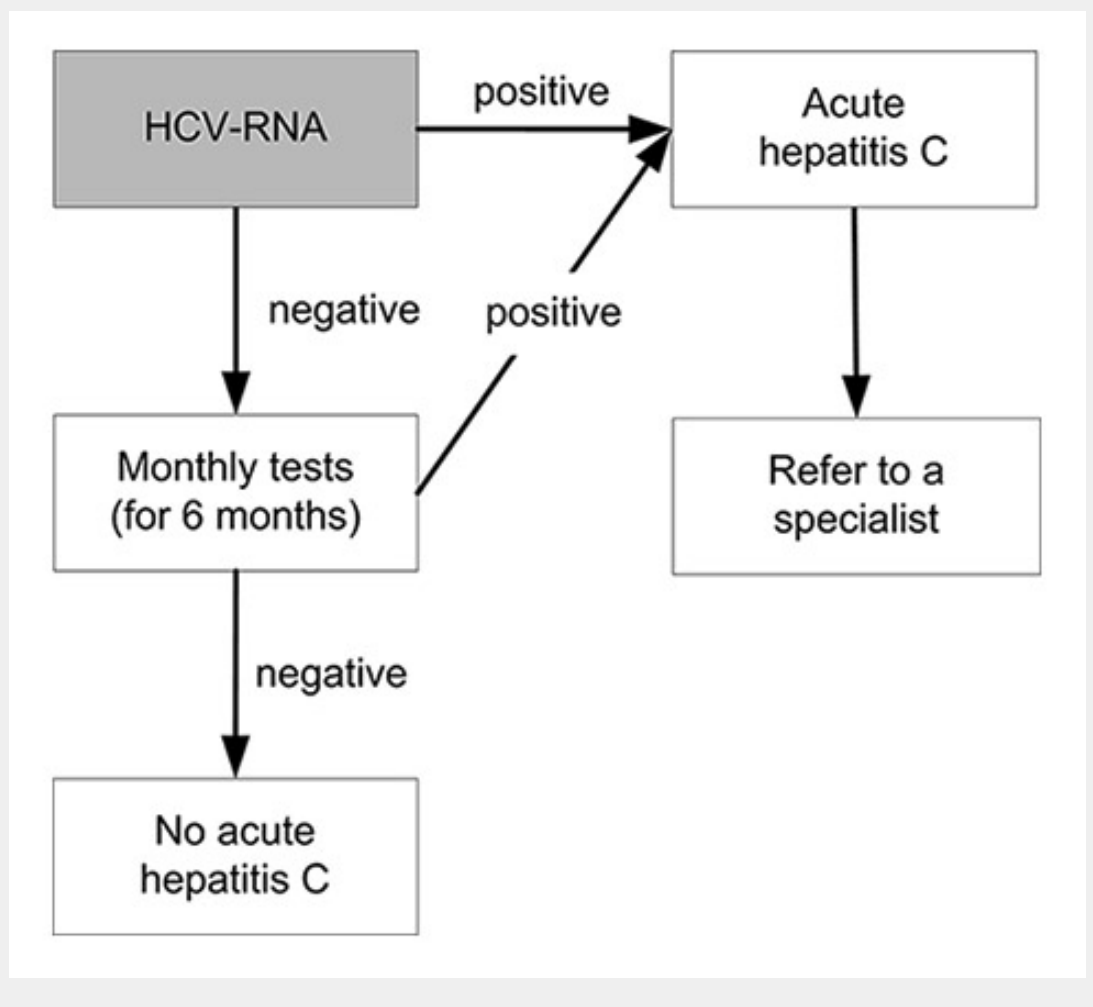
Figure 2 Testing for acute hepatitis C virus (HCV) infection after exposure: in the acute phase of infection HCV ribonucleic acid (RNA) becomes detectable before anti-HCV. A suspected acute HCV infection must be investigated by means of a HCV RNA